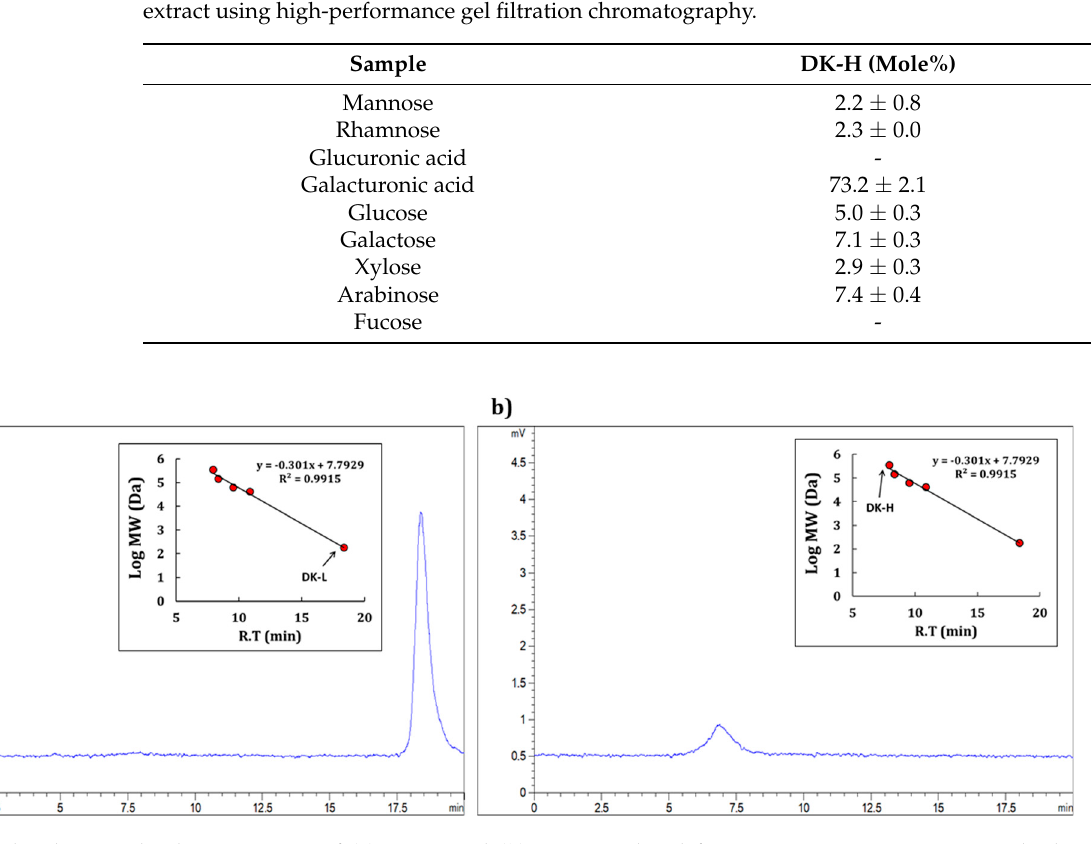
Figure 1 . Molecular weight determination of ( a ) DK-L and ( b ) DK-H isolated from persimmon extract using high-performance gel filtration chromatography. Each fraction was loaded into the chromatographic system equipped with a Superdex 200 Increase 10/300 GL packed column and an evaporative light scattering detector (ELSD). The calibration curve was prepared with pullulan standards with different molecular weights (p-180, p-41400, p-62600, p-144000, and p-345000).